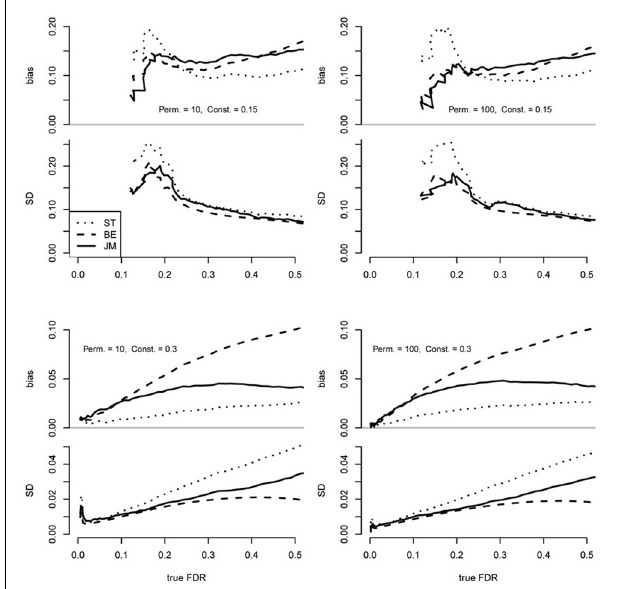
FIGURE 1 | Performance of the proposed FDR point estimator (JM; implemented in the “fdrci” R package) as compared to the Storey and Tibshirani approach (ST) as implemented in the “ q -value” R package and the Efron approach (BE) as implemented in the “locfdr” R package. Each plot was based on 200 replicate datasets independently simulated under identical conditions using the simz software (Efron, 2010a,b), where dependencies are determined by fixing the root mean squared correlation, denoted by α , of the raw data to 0.05. From each dataset, 2000 t -tests of 100 “cases” and 100 “controls” were generated, where false null hypotheses were defined by adding a constant to the raw simulated z -scores of “cases,” as described by Efron (2010b) and π 0 = 0 . 75. Data were simulated with 40 blocks of correlated z -scores according to α . Case-control labels were randomly permuted 10 or 100 times ( B ) for each scenario. Differing values of “true FDR” reflected a series of increasing significance thresholds. True FDR was computed from the simulated data as mean F / S . Bias was computed as the mean F ˆ DR—true